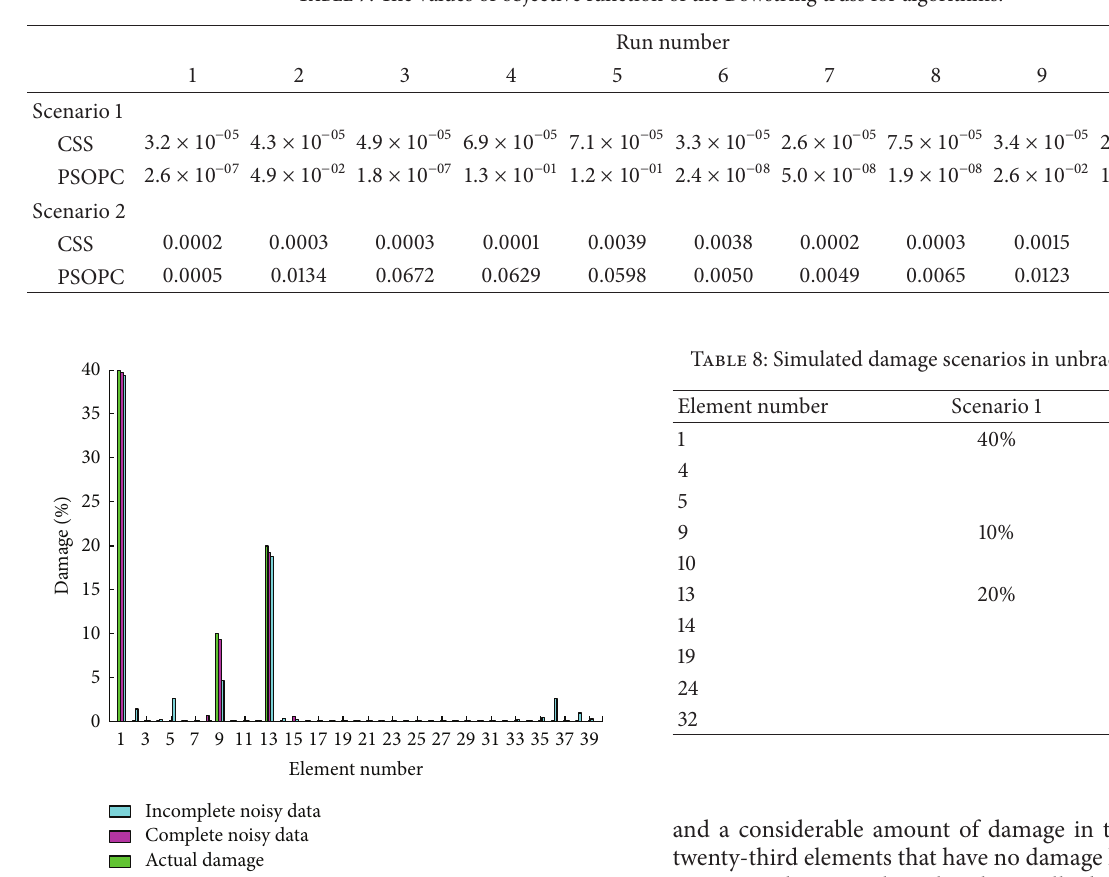
Table 7: The values of objective function of the Bowstring truss for algorithms.